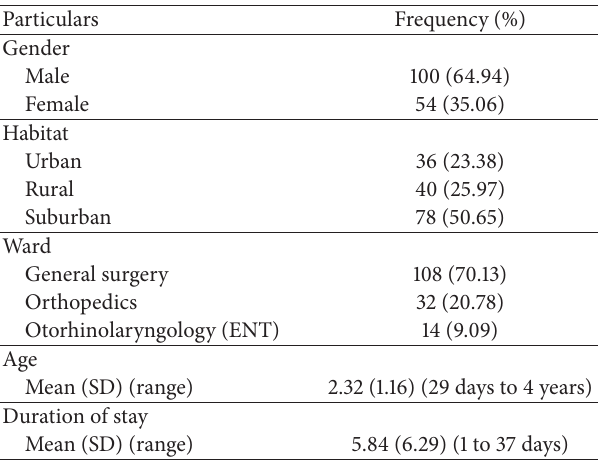
Table 1: Characteristics of the study population.